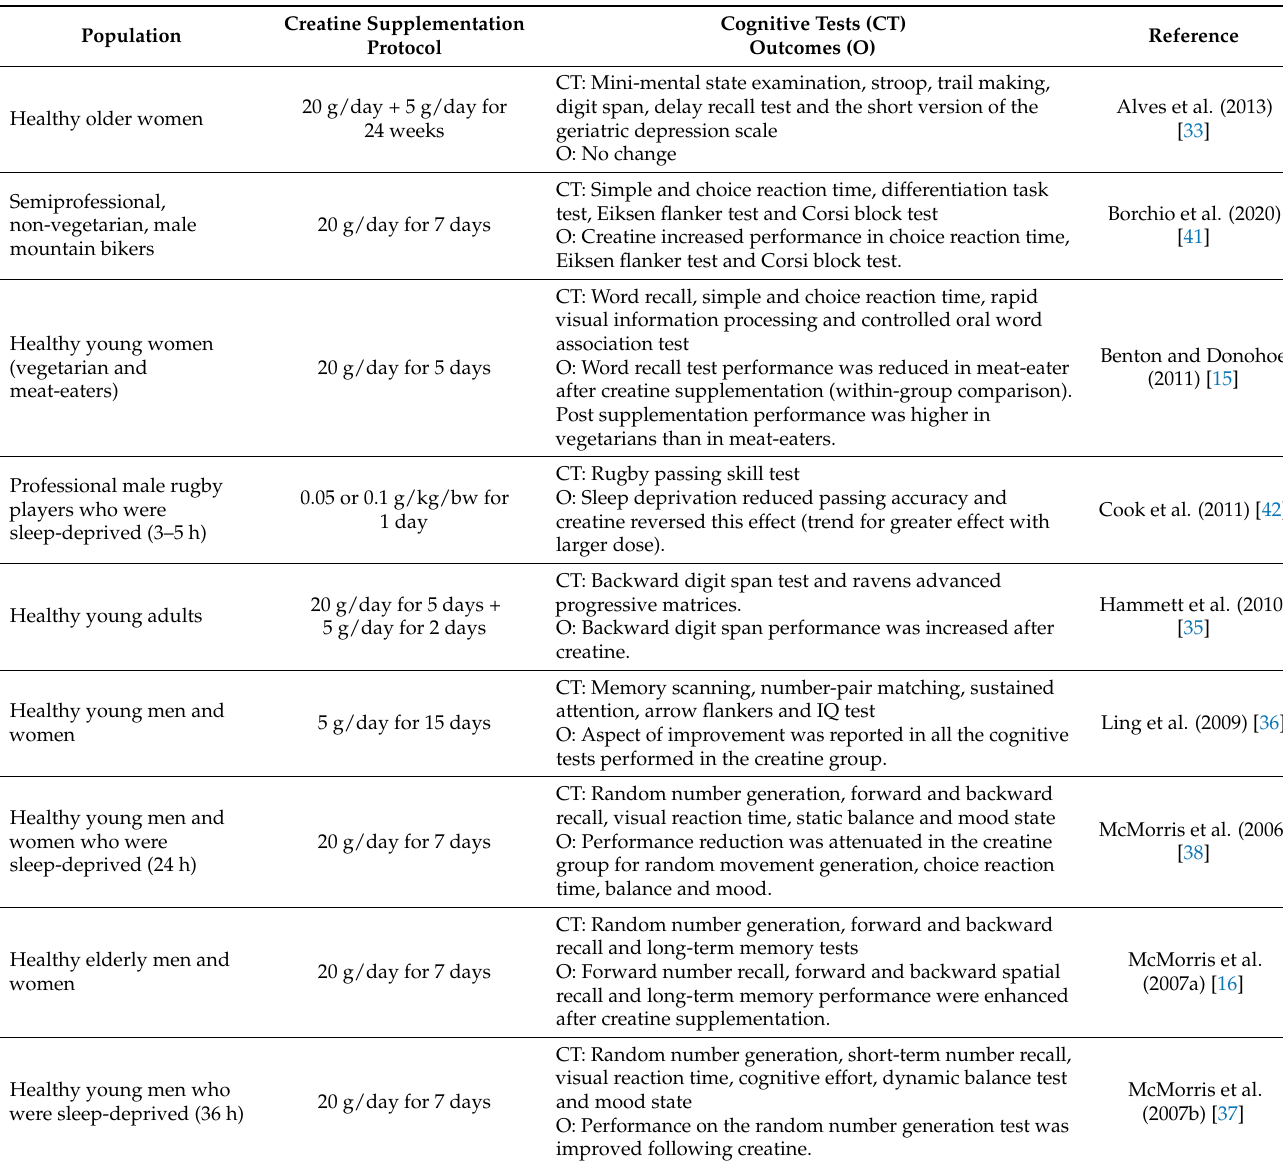
Table 1. Effects of creatine supplementation on cognitive